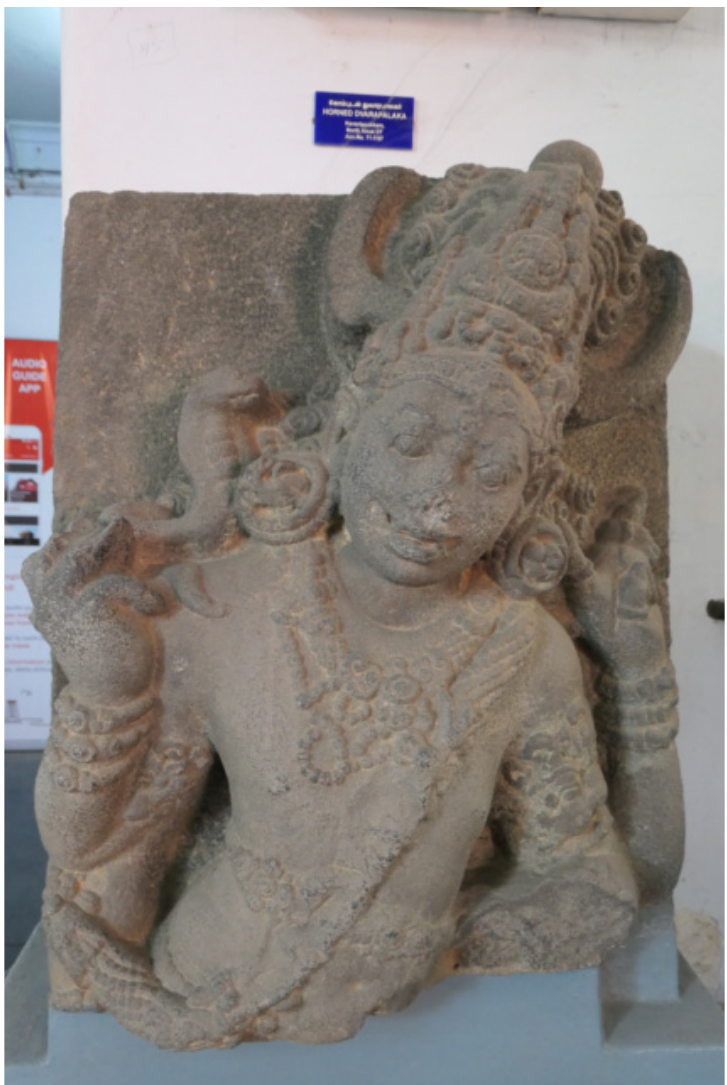
Figure 8. Door guardian, Kaveripakkam, Tamil Nadu, ca. 9th–mid-10th century. Government Museum, Chennai, 71-7/37. Photograph by Katherine E. Kasdorf.